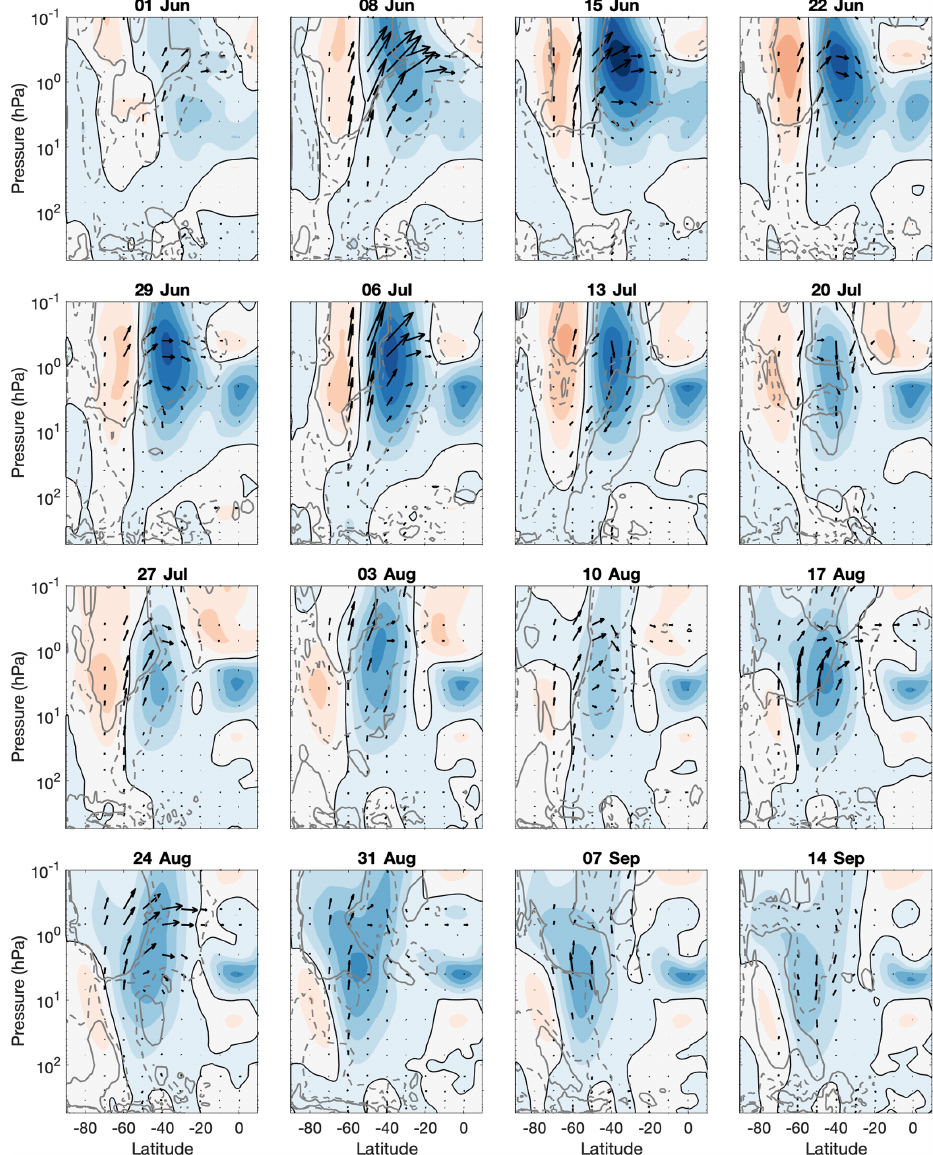
Figure 5. The same as Fig. 3 but showing the difference for the year